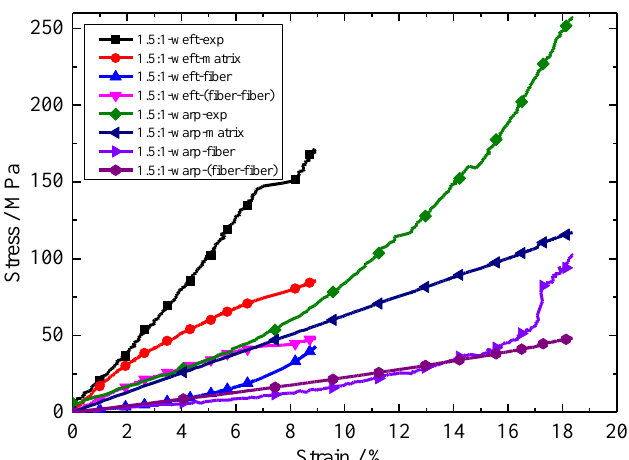
12 of 14 Figure 10. Comparison of test results and numerical models under different stress ratios. The relationships between each constituent of stress and experiment stress with strain under different stress ratios are shown in Figures 11 and 12. Here, in 1.5:1-weft-exp, 1.5:1 represents the stress ratios, weft represents the biaxial tension in the weft direction, and exp represents the experimental results. Other nomenclature rules such as 1.5:1-warp-exp are similar meaning to 1.5:1-